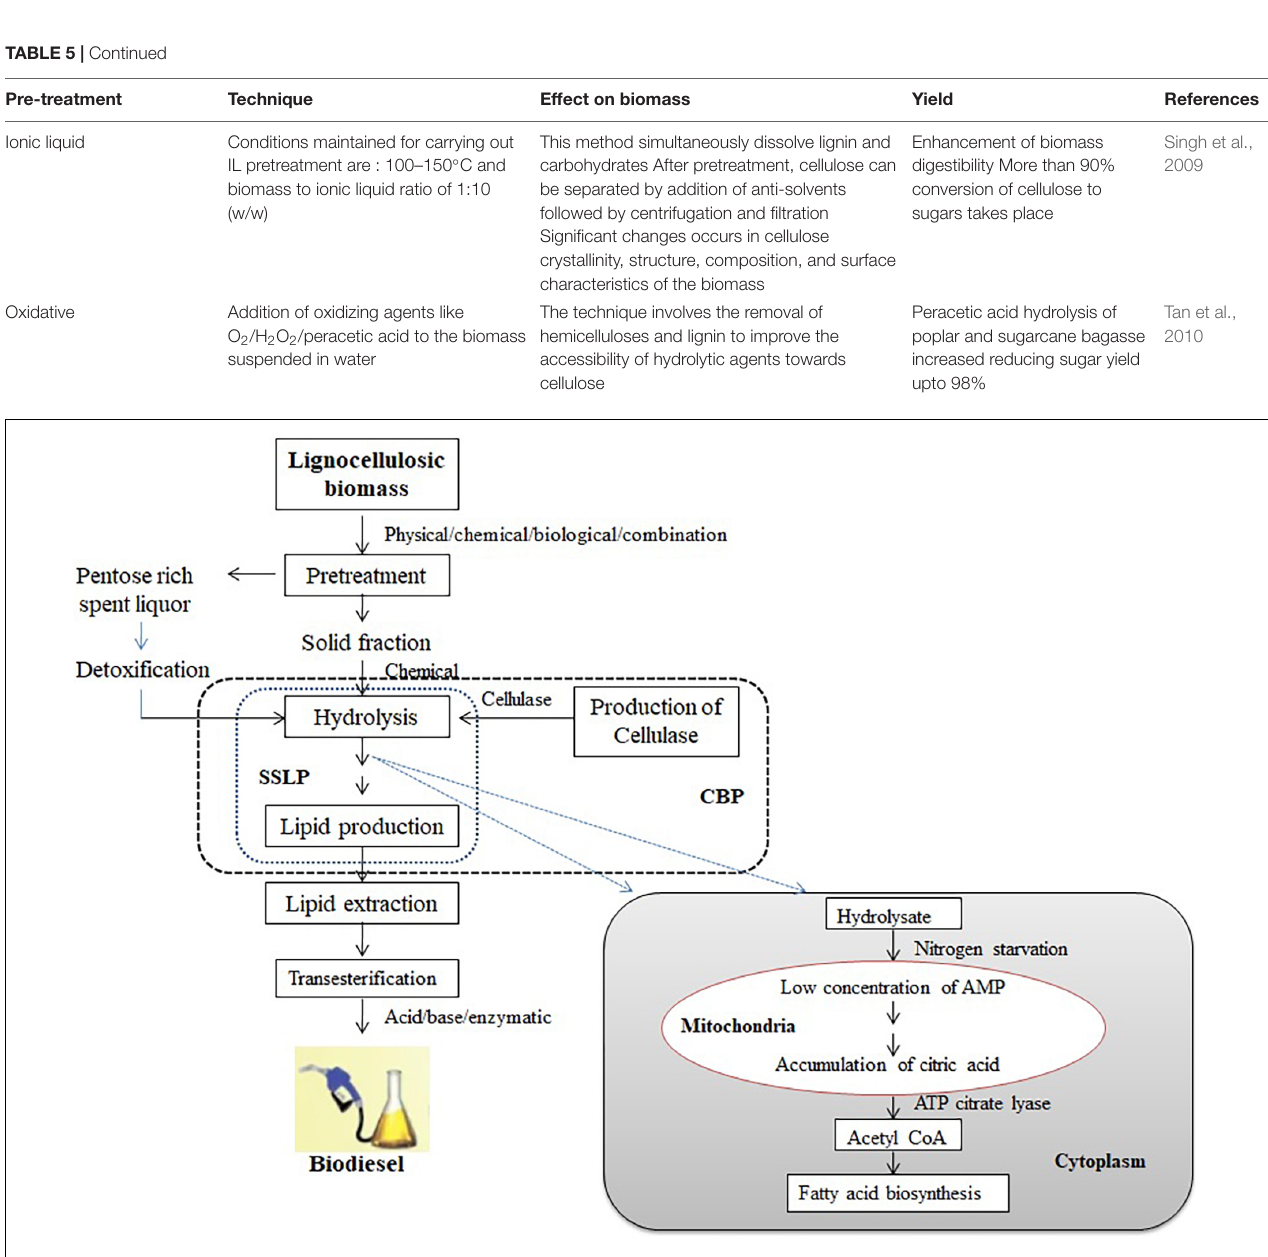
FIGURE 1 | Schematic diagram of lipid biosynthesis from lignocellulosic biomass using oleaginous microorganisms.